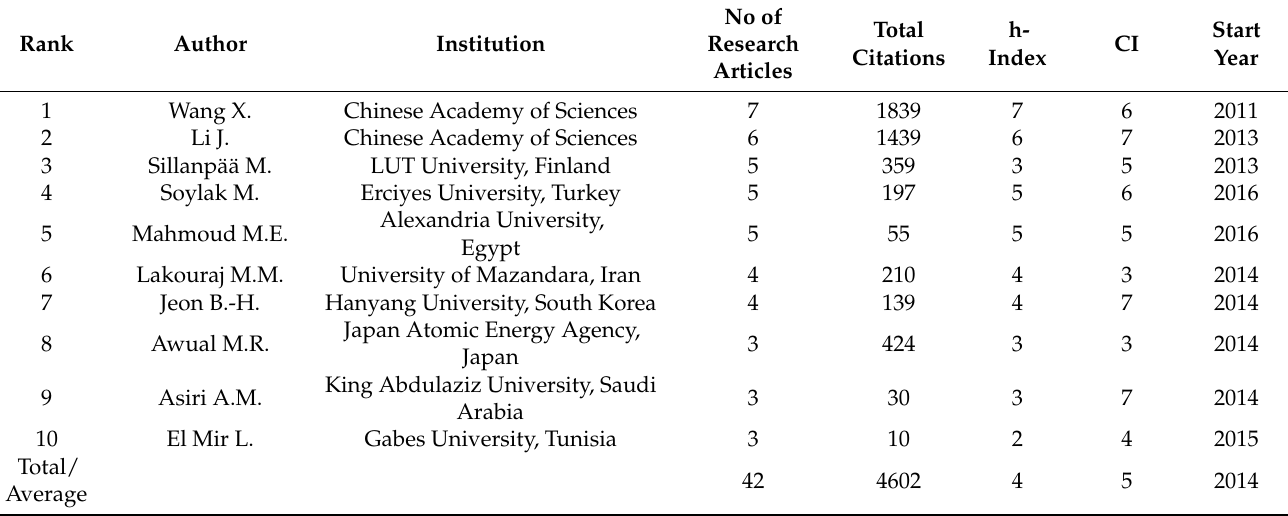
Figure 4. Collaboration network of top-10 prolific authors. Table 5. Top 10 productive